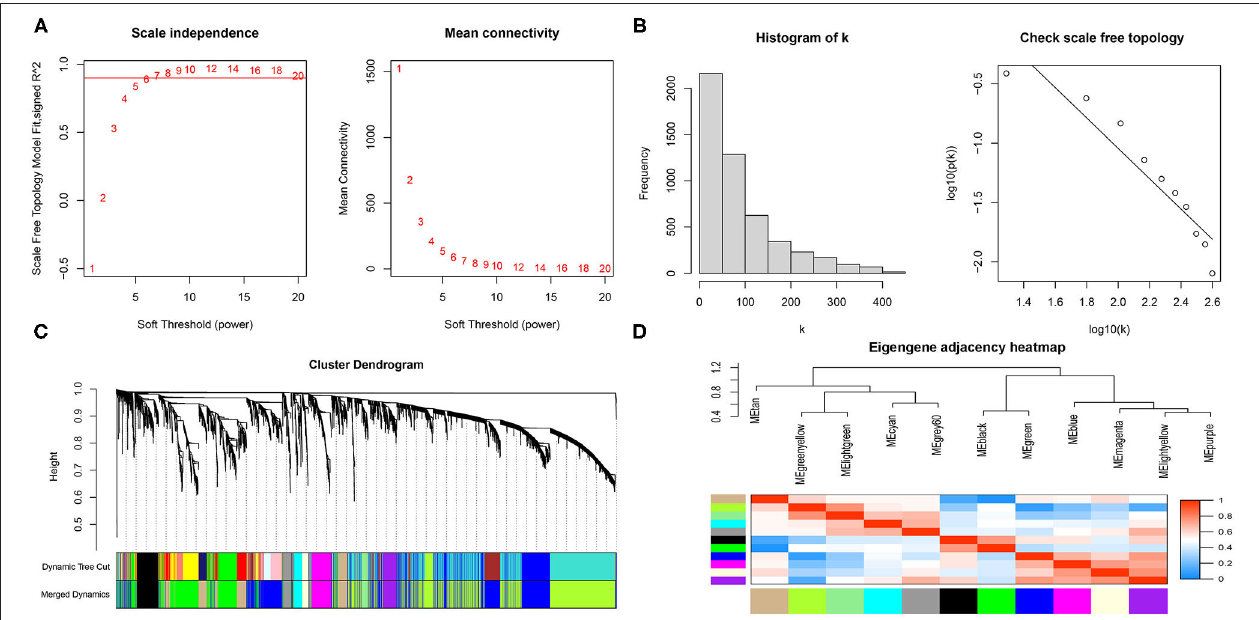
FIGURE 2 | Scale-free networks were constructed and genes were clustered by WGCNA. (A) Scale-free network analysis under different soft-thresholding powers. The left panel shows that scale-free topological indices at different soft-thresholding powers. The right panel shows the correlation analysis between the soft-thresholding powers and average connectivity of the network. (B) Histogram of connectivity distribution and checking the scale free topology when β = 6. (C) Gene clustering diagram based on hierarchical clustering under optimal soft-thresholding power. (D) Heatmap of the eigengene adjacency.